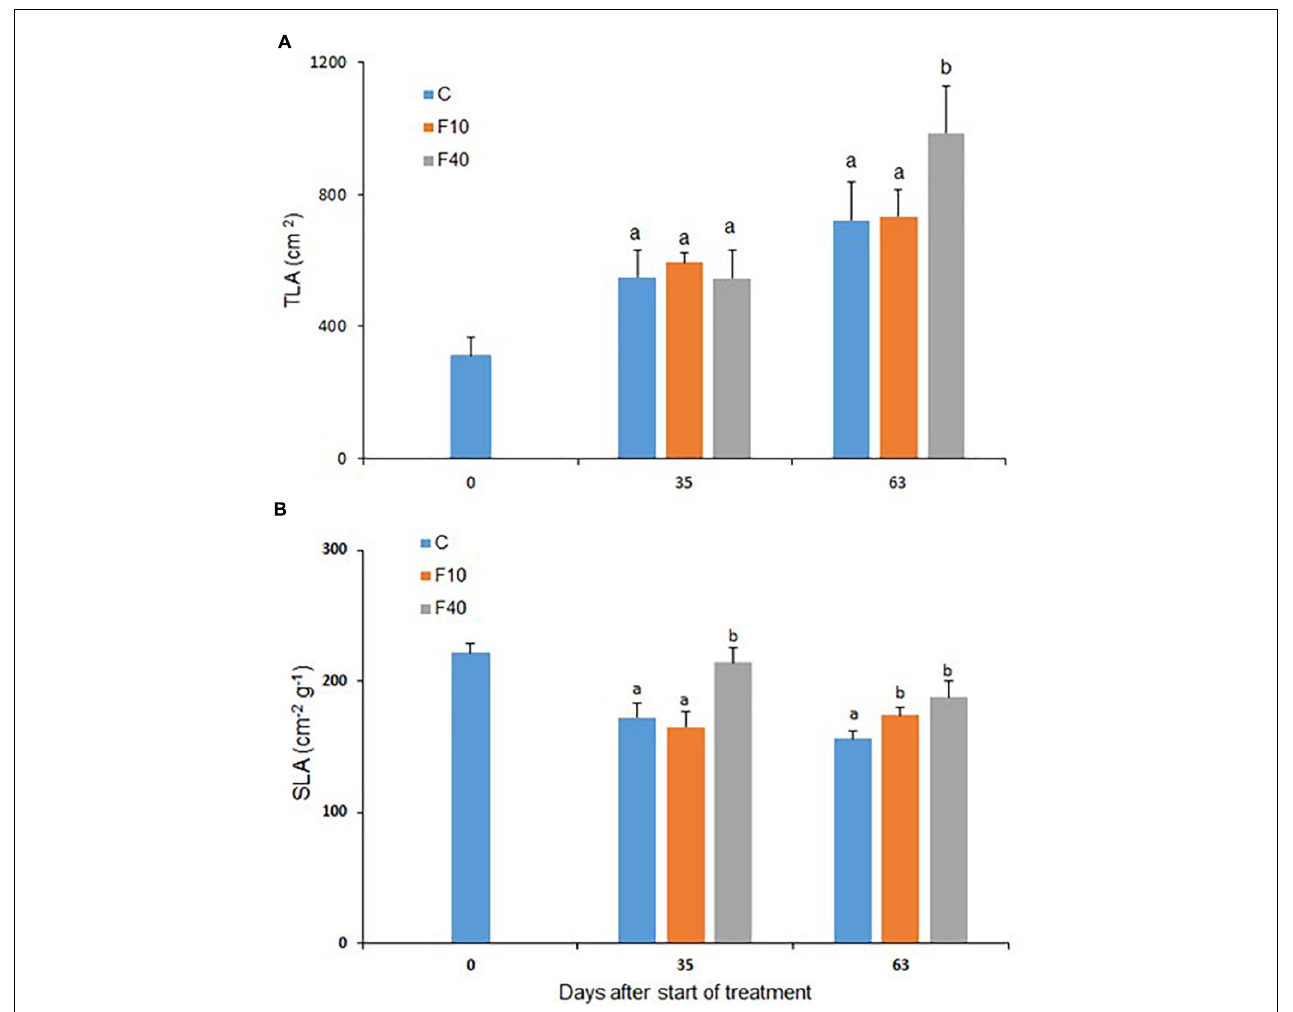
FIGURE 4 | Total leaf area (A) and specific leaf area (B) for C (Control), F10, and F40 treatments at the beginning of the experiment (Day 0), at the end of the flooding period (Day 35), and at the end of the post-flooding recovery period (Day 63). Means followed by the same letter did not differ according to Tukey’s test ( p < 0.05, N = 4–8). Vertical bar: standard